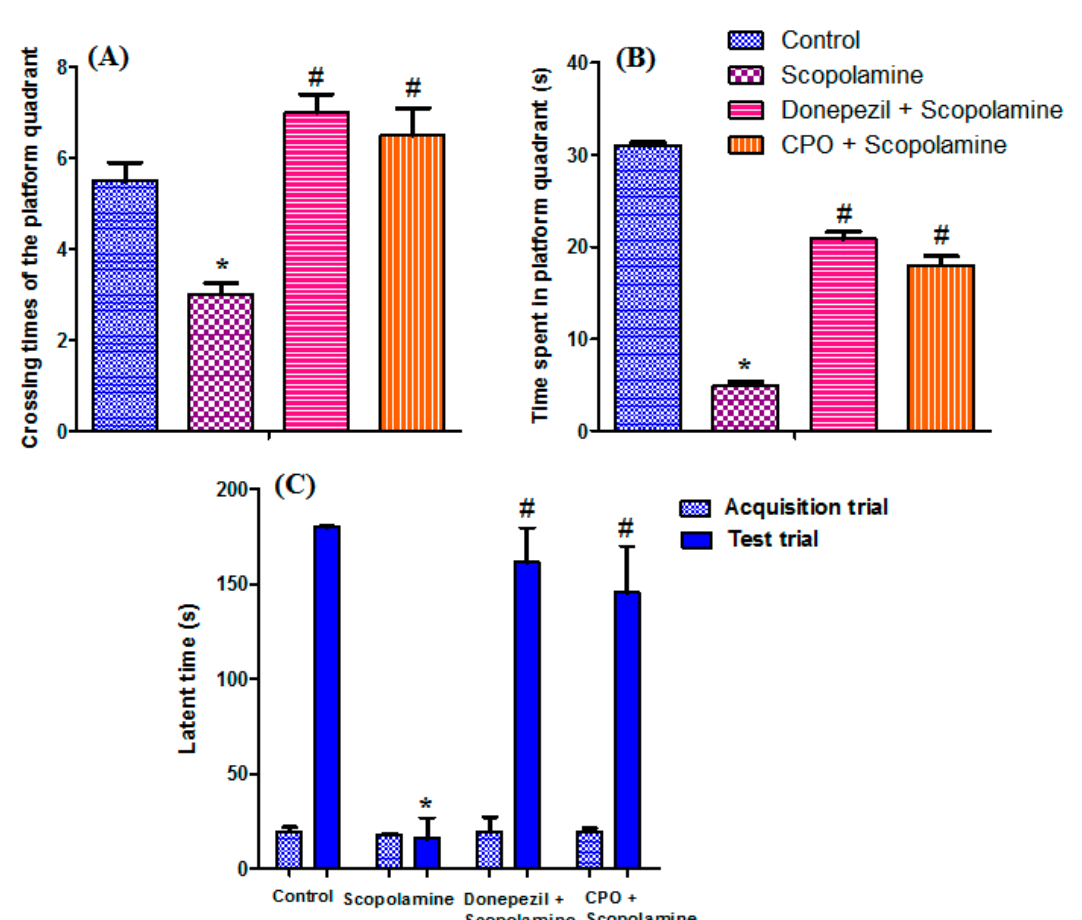
Figure 1. Effect of cold-pressed pepper oil on Morris water maze ( A , B ) and passive avoidance tests ( C ). Data are expressed as mean ± SEM, n = 6. *, significant difference ( p < 0.05) from the control group, #, significant difference ( p < 0.05) from the SC-treated group. This figure was adopted from Mostafa [10].